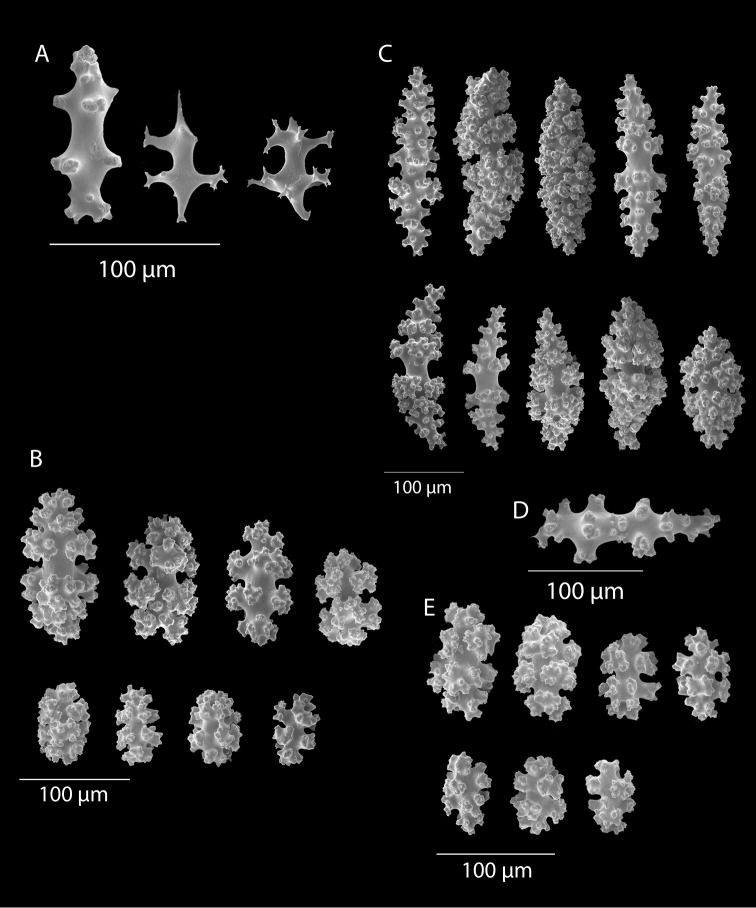
Chromoplexauramarki, SBMNH 423060, SEM image. A Anthocodial sclerites B Small coenenchymal forms C Larger, distinctive “double dunce-cap” spindles D Odd spindle E Still smaller coenenchymal sclerites. Images match variety shown in Williams 2013a (figs 14–17).